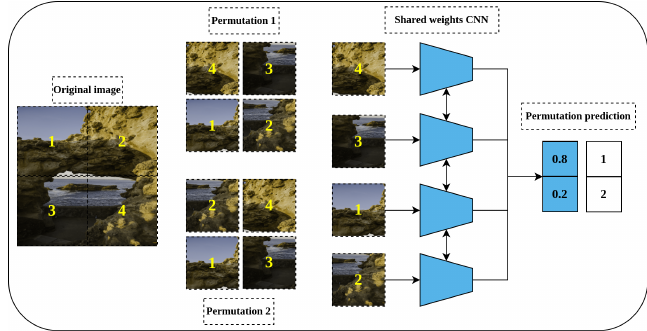
Figure 12. Example of Jigsaw pretext task (DOI: 10.7717/peerjcs.1045/fig-5).